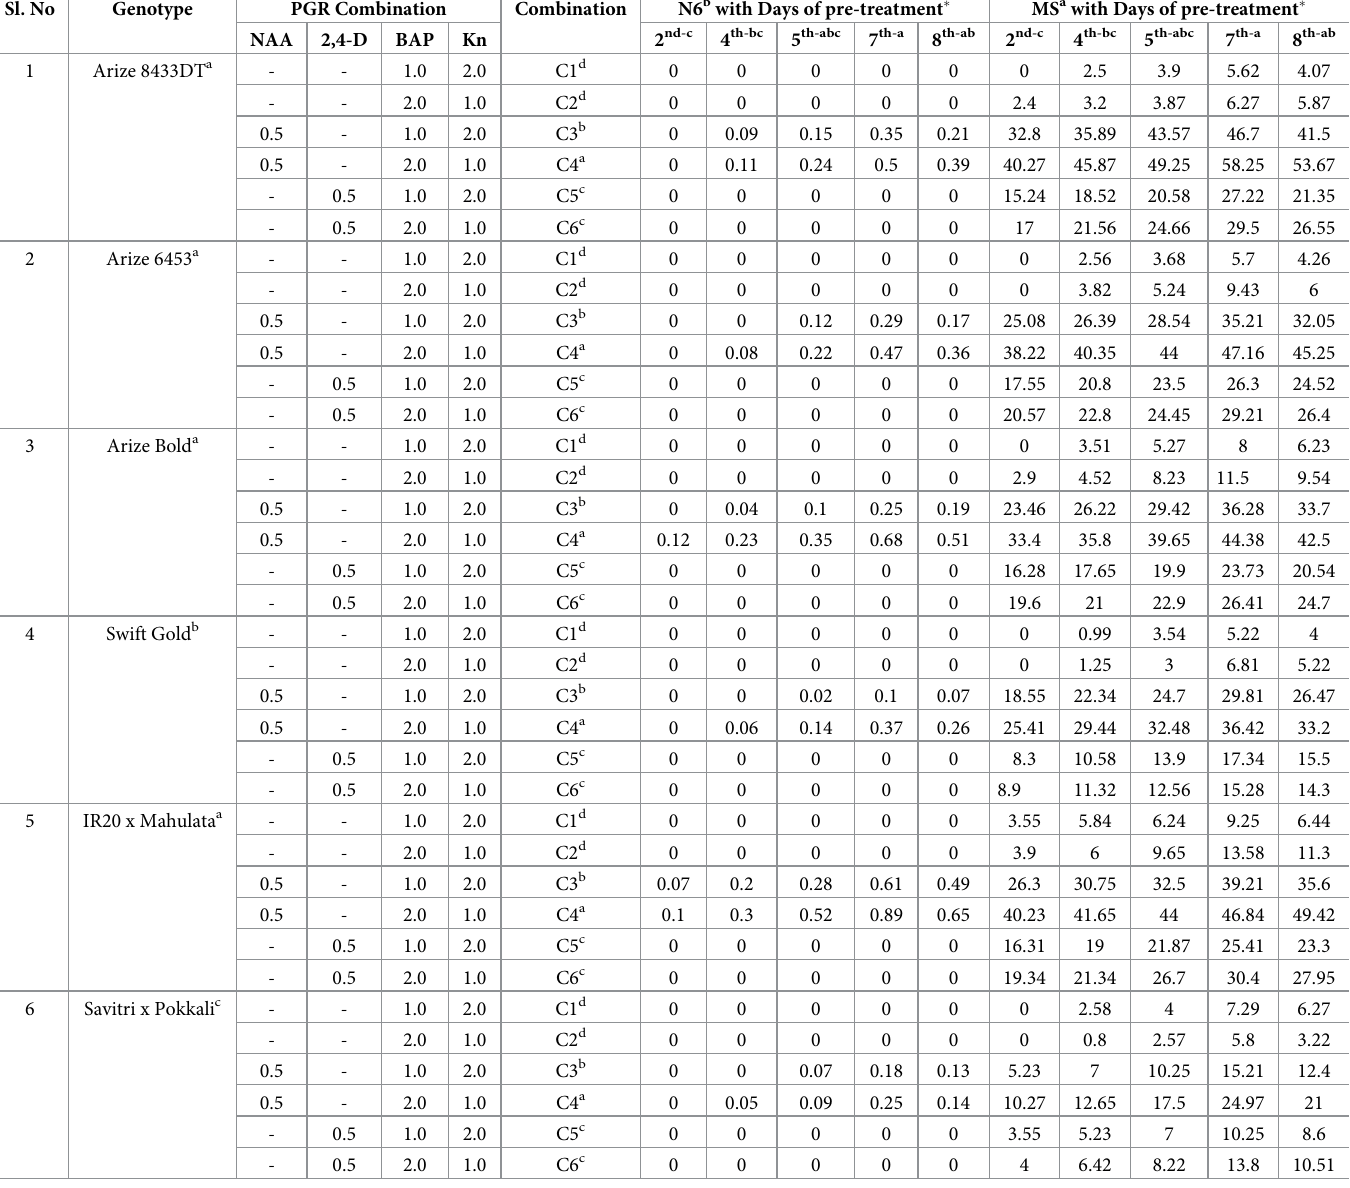
Table 2. Regeneration (%) against basal media type for each days of pre-treatment. Sl. No Genotype